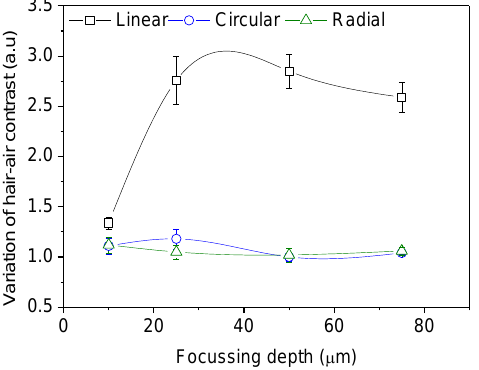
Figure 4. Variation of hair-air contrast measured on non-medullated black hair ( ex-vivo ) as a function of focusing depth inside hair for different orientations of incident polarizations.